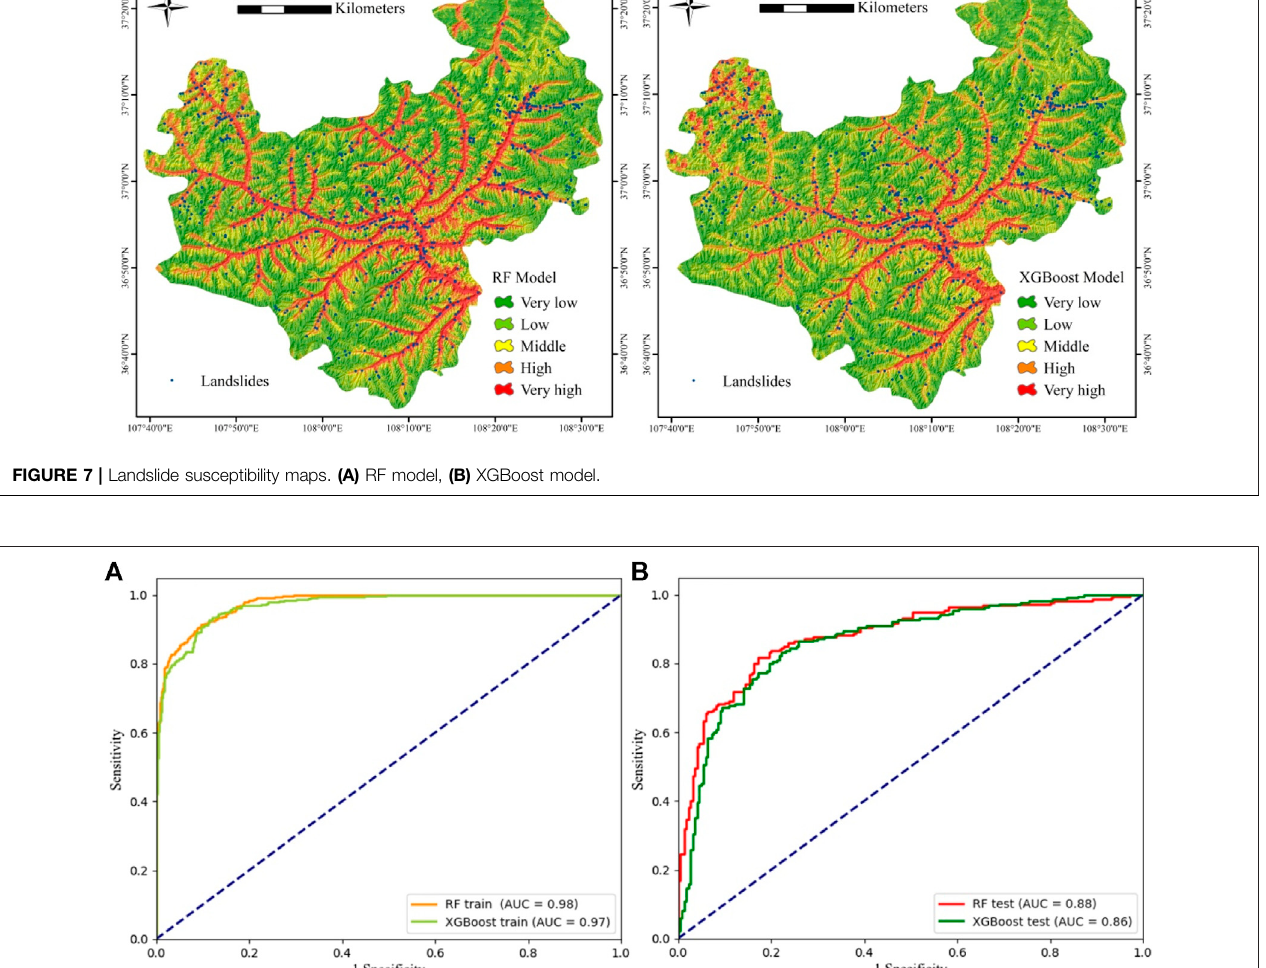
Frontiers in Earth Science |